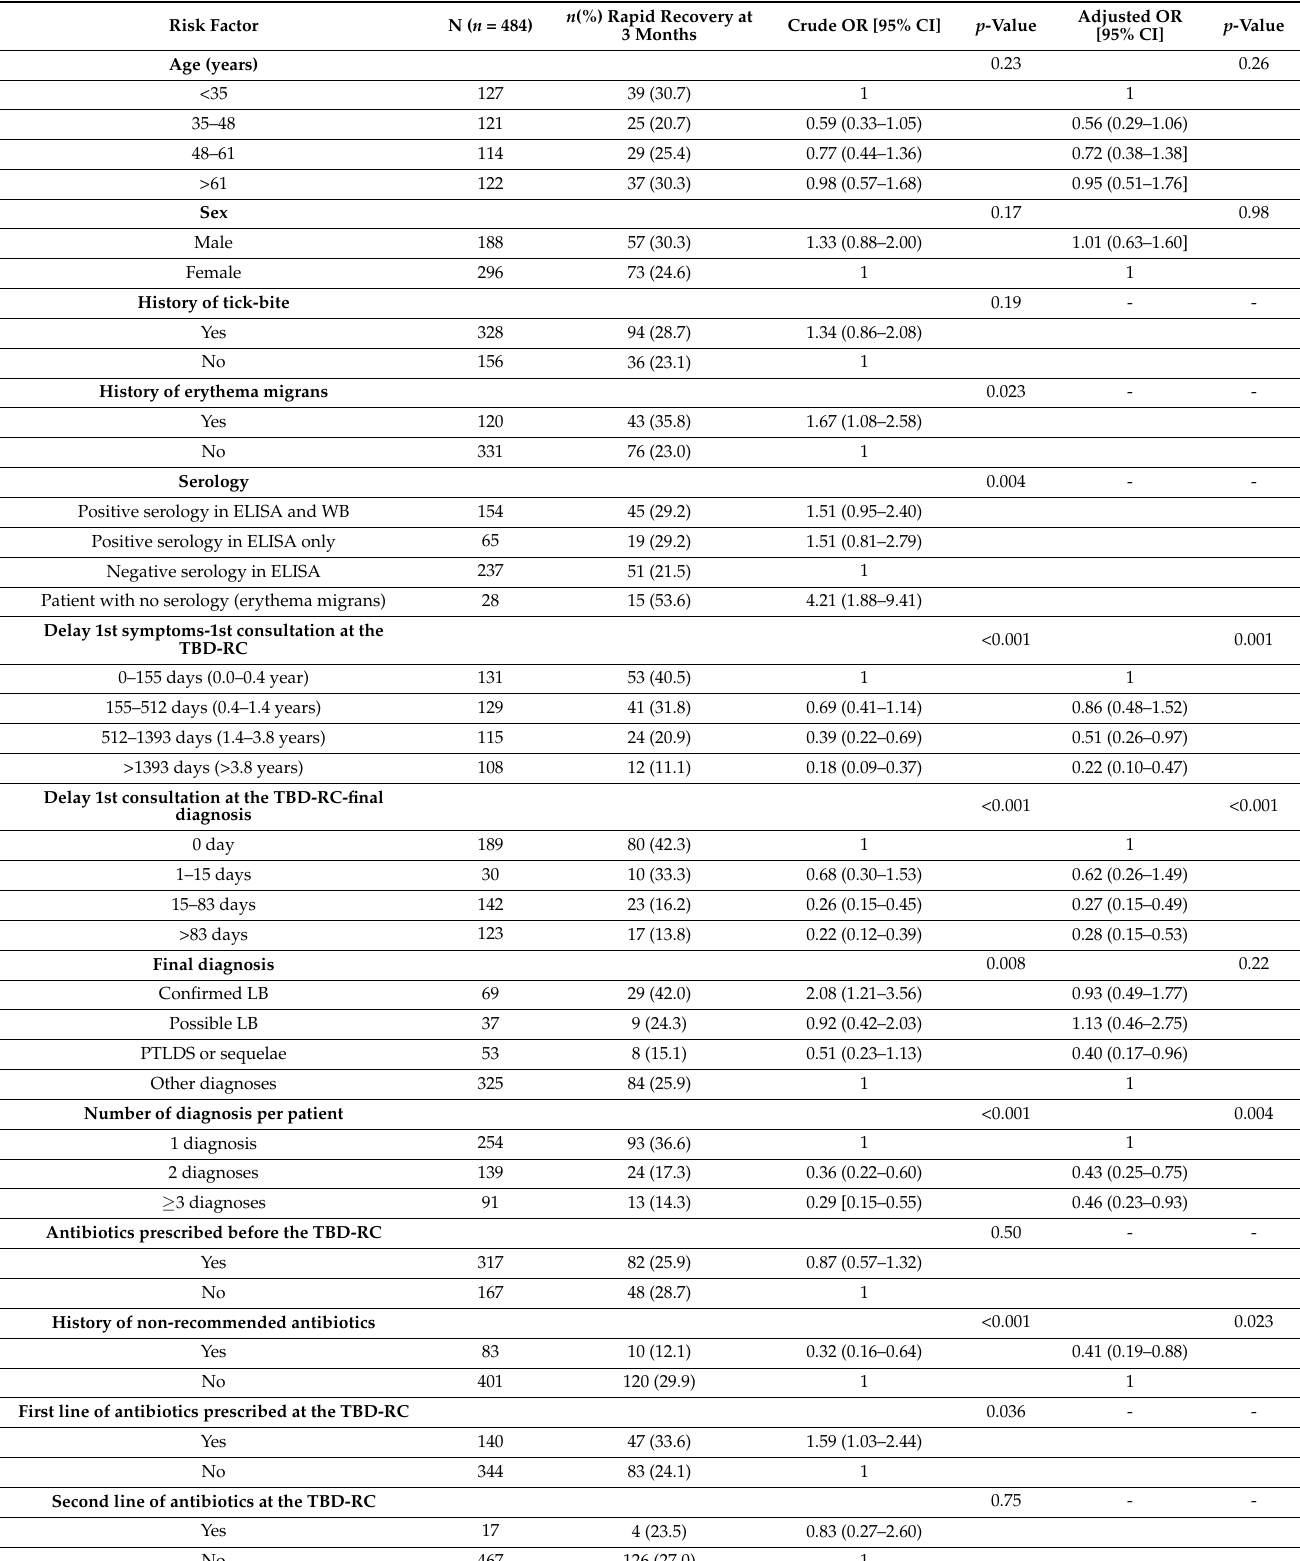
Table 5. Univariate and multivariate analyses of the associated factors with recovery versus partial improvement or stagnation or deterioration at three months after care at the TBD-RC-Paris and Northern